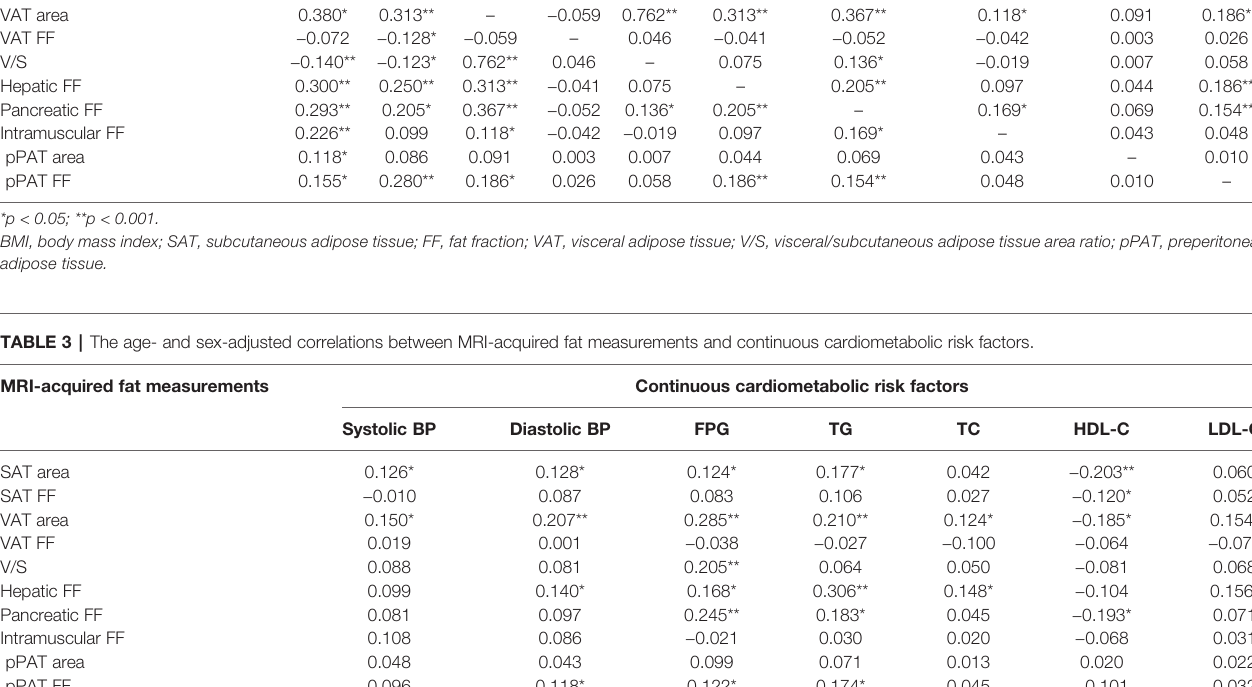
TABLE 2 | The age- and sex-adjusted correlations among MRI-acquired fat measurements in all patients. MRI-acquired fat measurements SAT area SAT FF VAT area VAT FF V/S Hepatic FF Pancreatic FF Intramuscular FF pPAT area pPAT FF SAT area